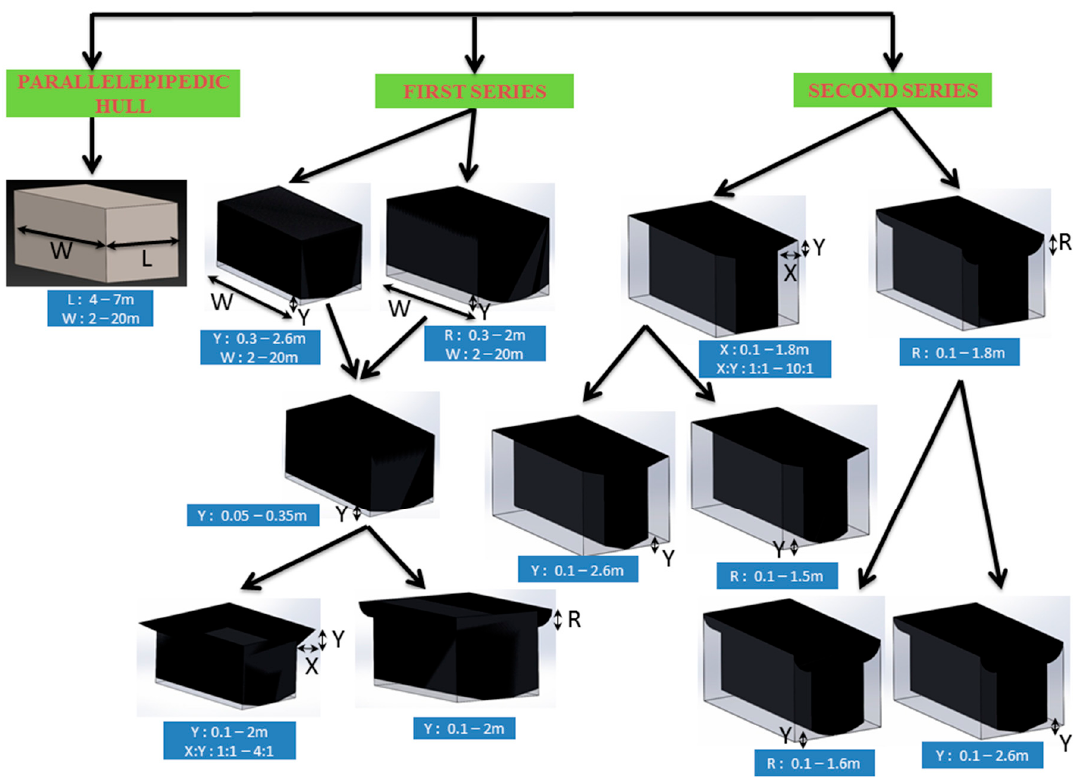
Figure 5. Flowchart of investigation of various shapes and their variation ranges for the optimization process.